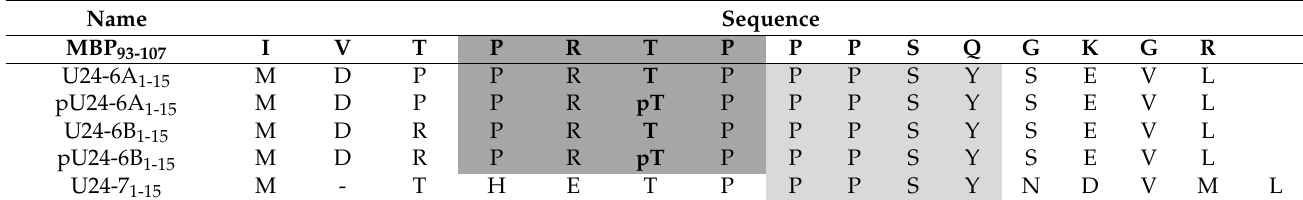
Table 1. Sequence alignment of myelin basic protein (MBP) and U24 from HHV-6A (U24-6A), -6B, and -7. The PxxP motif is indicated in dark gray, whereas the PY motif is shown in light gray. The subscript in the name of the peptide represents the residue numbers, with the numbering of MBP based on the human 18.5 kDa classic isoform. Negatively charged side-chains are shown in blue, while positively charged residues are in red. The phosphorylated peptides (pU24-6A and pU24-6B) are also included, with pT representing phospho-threonine. 15 residue peptides, with the sequences given here, were used in this